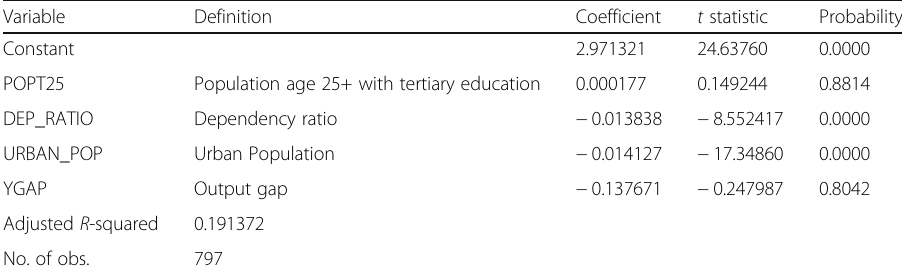
Table 3 WPR vs demographic factors and the state of the business cycle